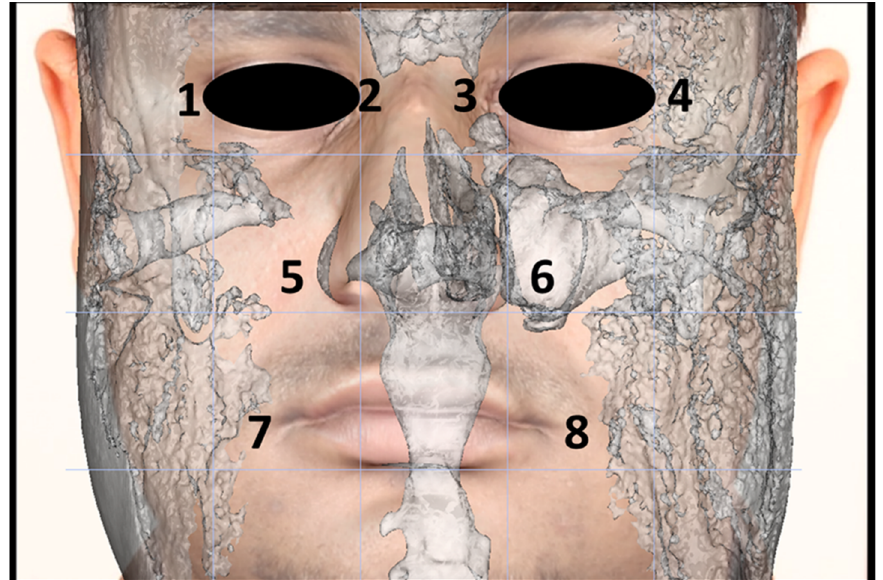
Figure 3. The eight CBCT wrapping points: ( 1 ) right lateral canthus, ( 2 ) right medial canthus, ( 3 ) left medial canthus, ( 4 ) left lateral canthus, ( 5 ) right nasolabial creases, ( 6 ) left nasolabial creases, ( 7 ) right oral commissure, and ( 8 ) left oral commissure.